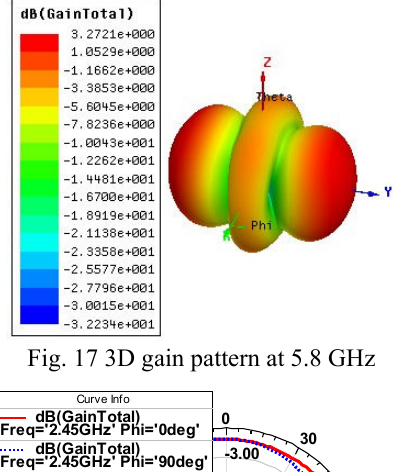
Fig. 17 3D gain pattern at 5.8 GHz